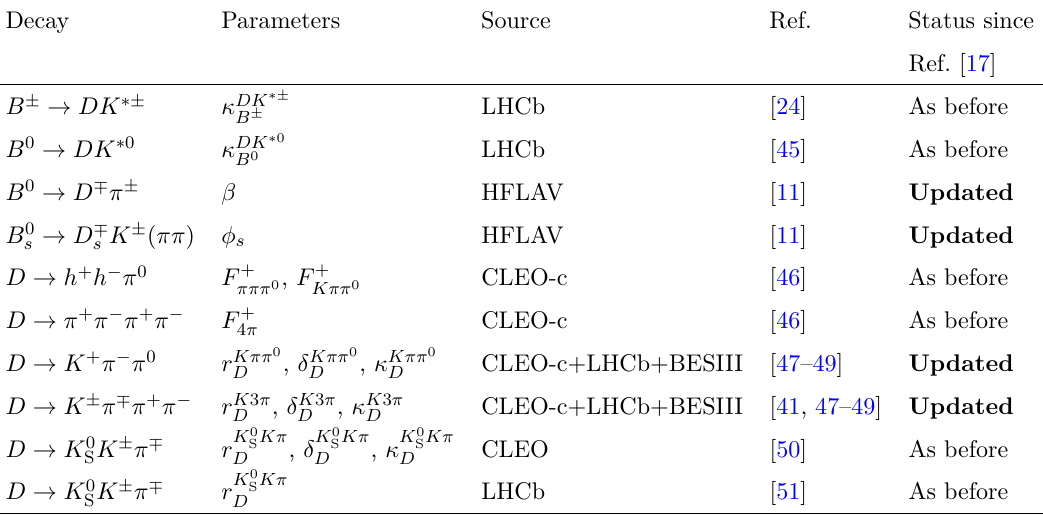
Table 2 . Auxiliary inputs used in the combination. Those highlighted in bold have changed since the previous combination